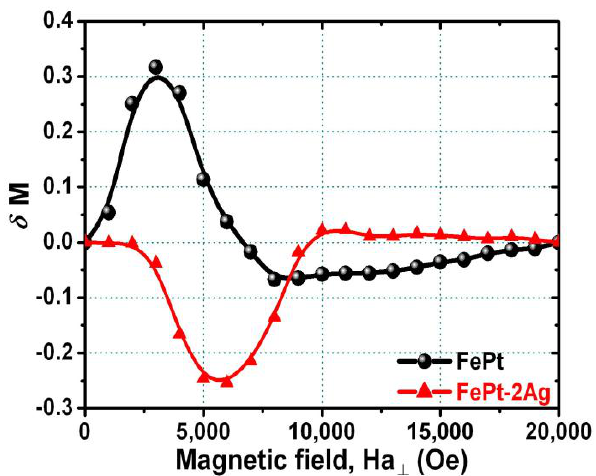
Figure 5. Kelly-Henkel ( δ M ) plot for the [Fe/Pt] 18 multilayer films without and with insertion of two ultrathin Ag (0.5 nm each) nanolayers. The magnetic field was applied in the out-of-plane direction to the film.